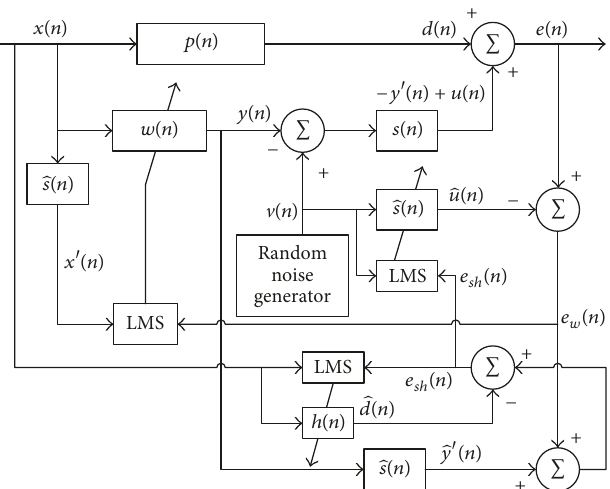
Figure 2: Yang’s method with online error channel identification.